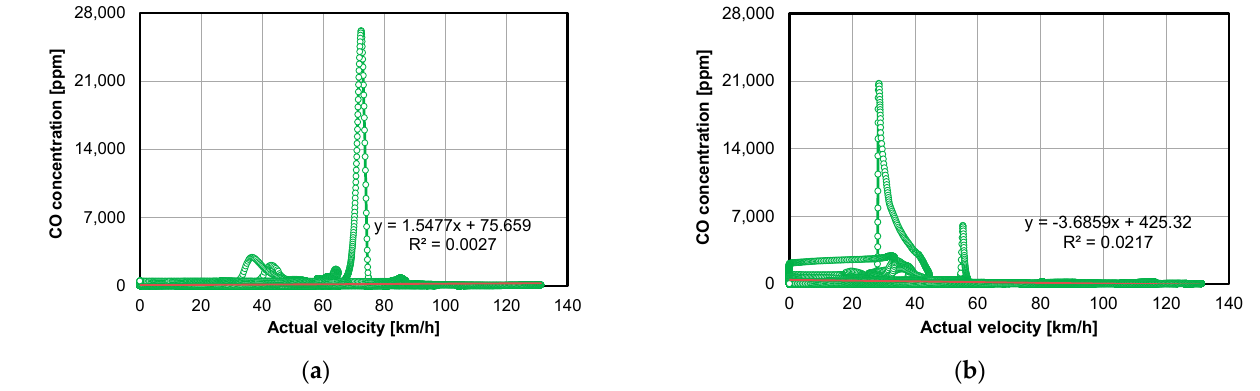
Figure 12. The CO concentration versus actual velocity for: ( a ) plug-in; ( b ) HEV.